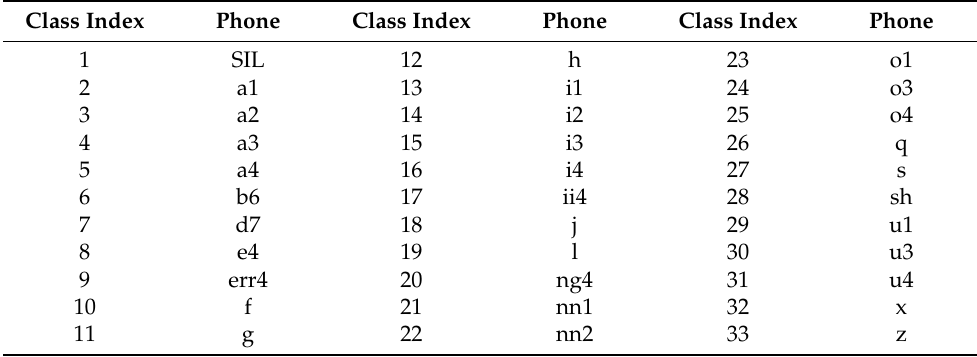
Table A2. The 33 phones applied in this study and correlated class index.